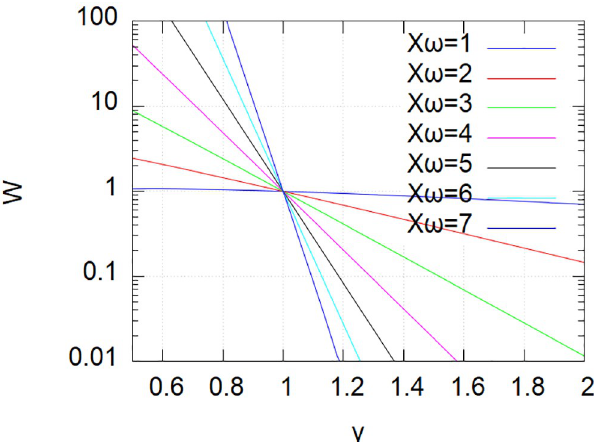
Fig 2. Variation of W with the relative diversity γ for different values of X ω . See